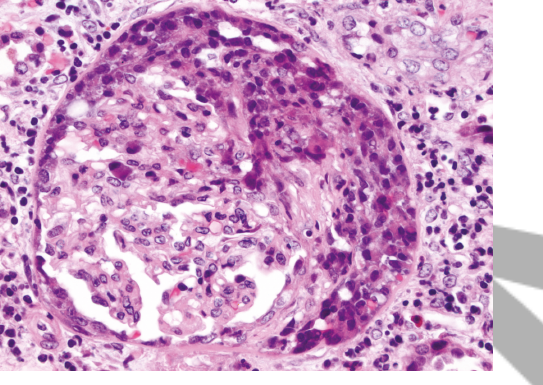
Figure 2: H&E stains showing crescentic glomerulonephritis with moderate interstitial inflammation and mild fibrosis with no evi- dence of vasculitis.